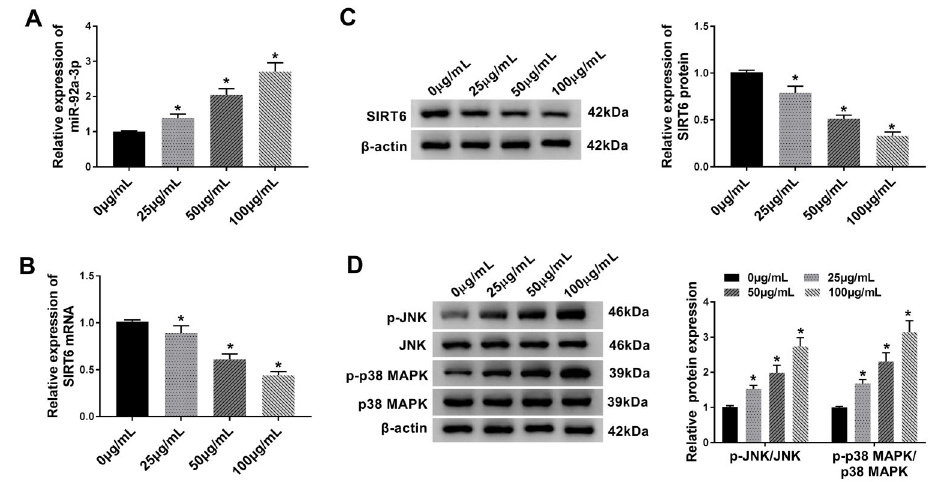
Figure 2. Expression levels of miR-92a-3p and SIRT6 in oxidized low-density lipoprotein (ox-LDL)-treated human umbilical vein endothelial cells (HUVECs). A , The relative expression level of miR-92a-3p was evaluated by RT-qPCR assay in ox-LDL-treated HUVECs. B and C , RT-qPCR and western blot assays were utilized to determine the mRNA and protein expression levels of SIRT6. D , Protein expression levels of p-JNK/JNK and p-p38 MAPK/p38 MAPK were analyzed with western blot assays in HUVECs. Data are reported as means ± SD with three replicates. *P o 0.05 compared to control